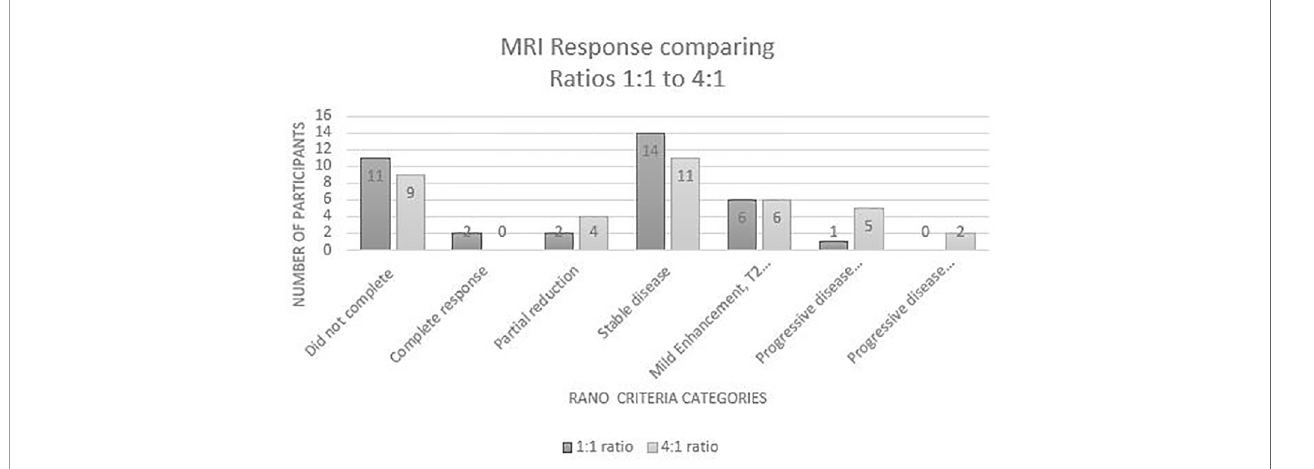
FIGURE 2 | MRI responses from Baseline to Week